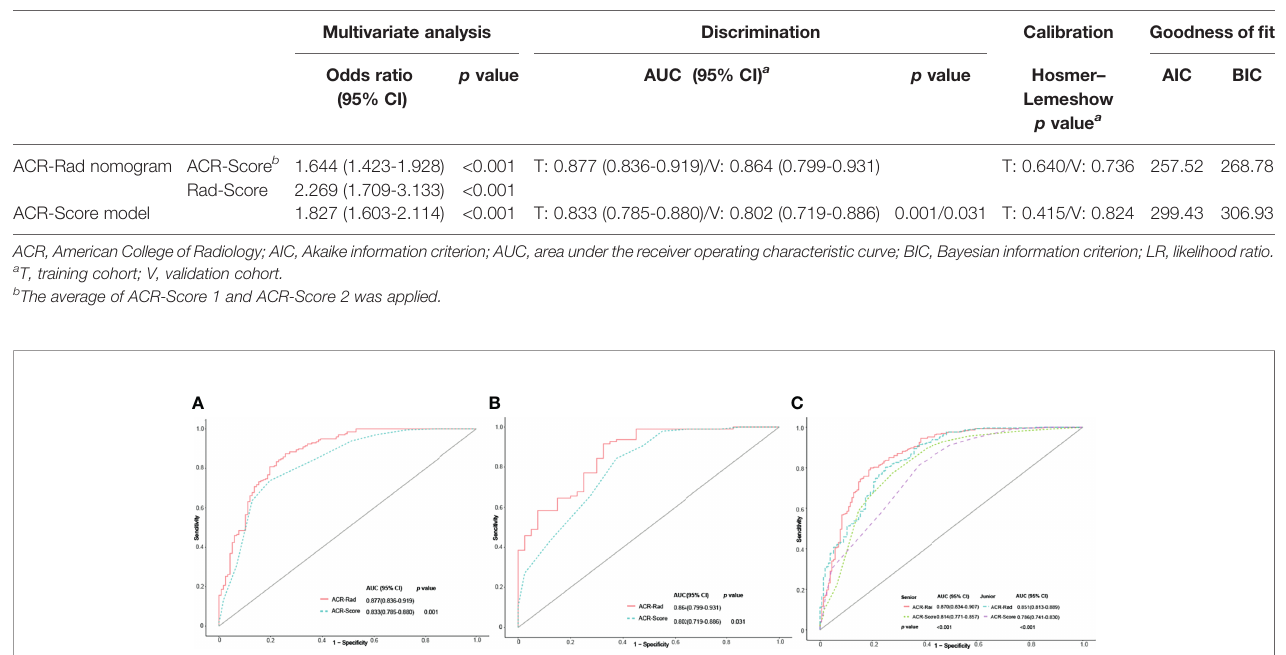
TABLE 3 | Performance of the ACR-Rad nomogram for predicting malignant thyroid nodules in the training and validation cohorts.